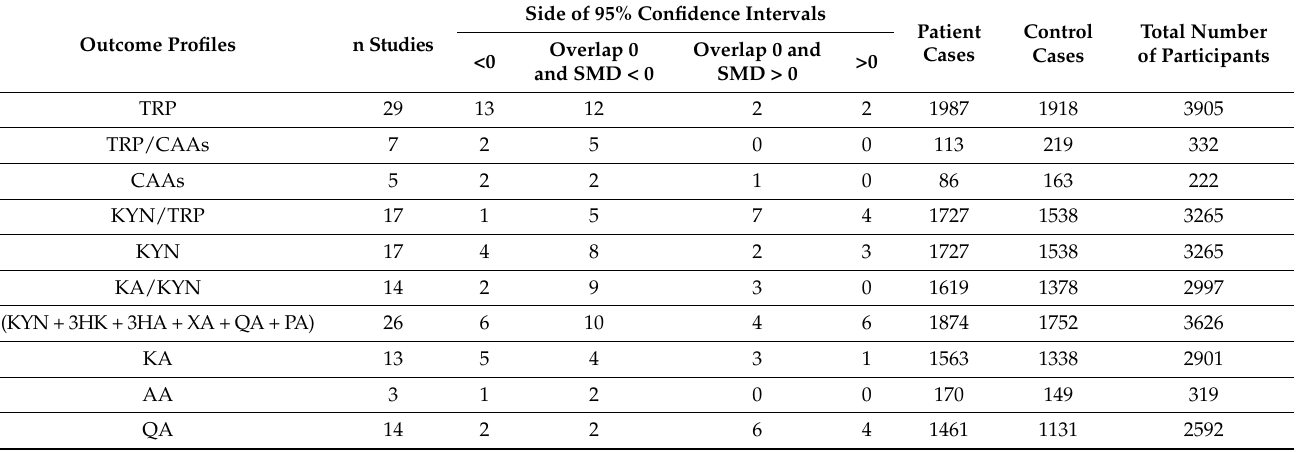
Table 1. The outcomes and number of patients with affective disorders and healthy control along with the side of standardized mean difference (SMD) and the 95% confidence intervals with respect to zero